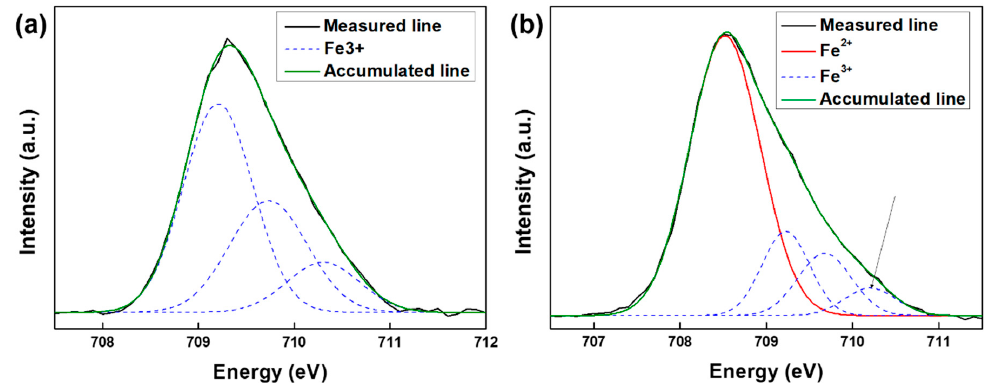
Figure 4. Background-substracted Fe 2p3 / 2 spectra from CN66 with solution-treated and air cooling ( a ) and water quenching ( b ), observed by X-ray photoelectron spectroscope.